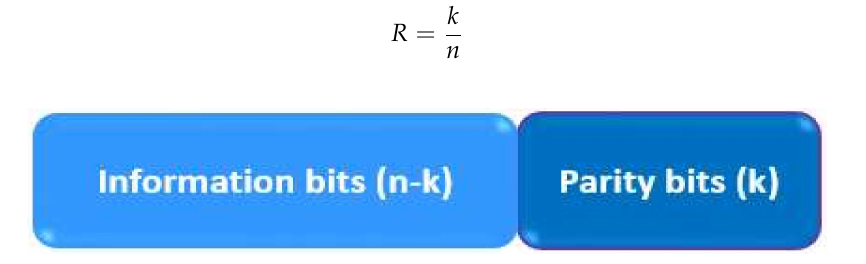
Figure 2. Illustration of Block Code with codeword length n